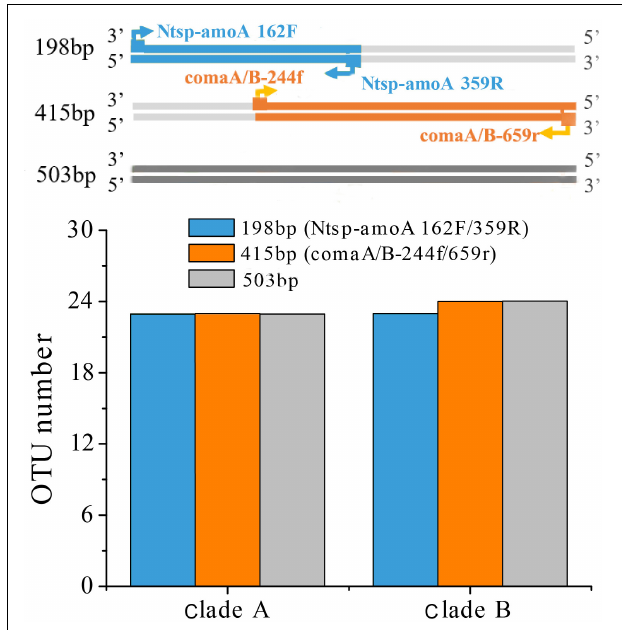
FIGURE 6 | OTU cluster analysis with 95% similarity cutoffs of comammox amoA gene sequences for clade A (115 sequences) and B (112 sequences) with length ≥ 503 bp from the NCBI-nr database covering both regions amplified by two primer sets at 198 bp-length (Ntsp-amoA 162F/359R), 415 bp-length (comaA/B-244f/659r) amplification regions and 503 bp-length